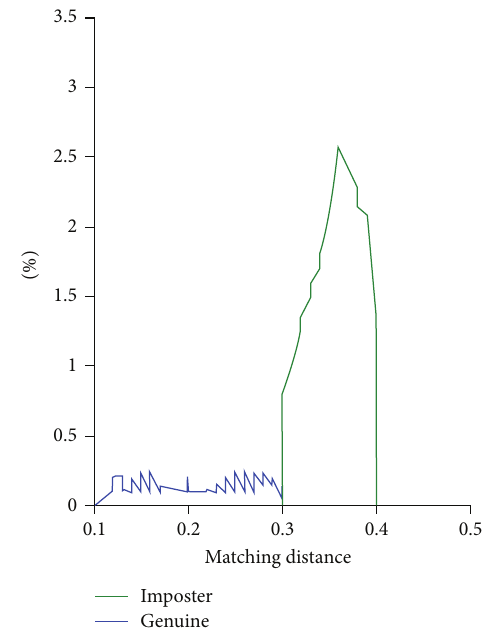
Figure 21: Distance distributions of genuine matching and imposter matching of proposed DOST for COEP palmprint database.